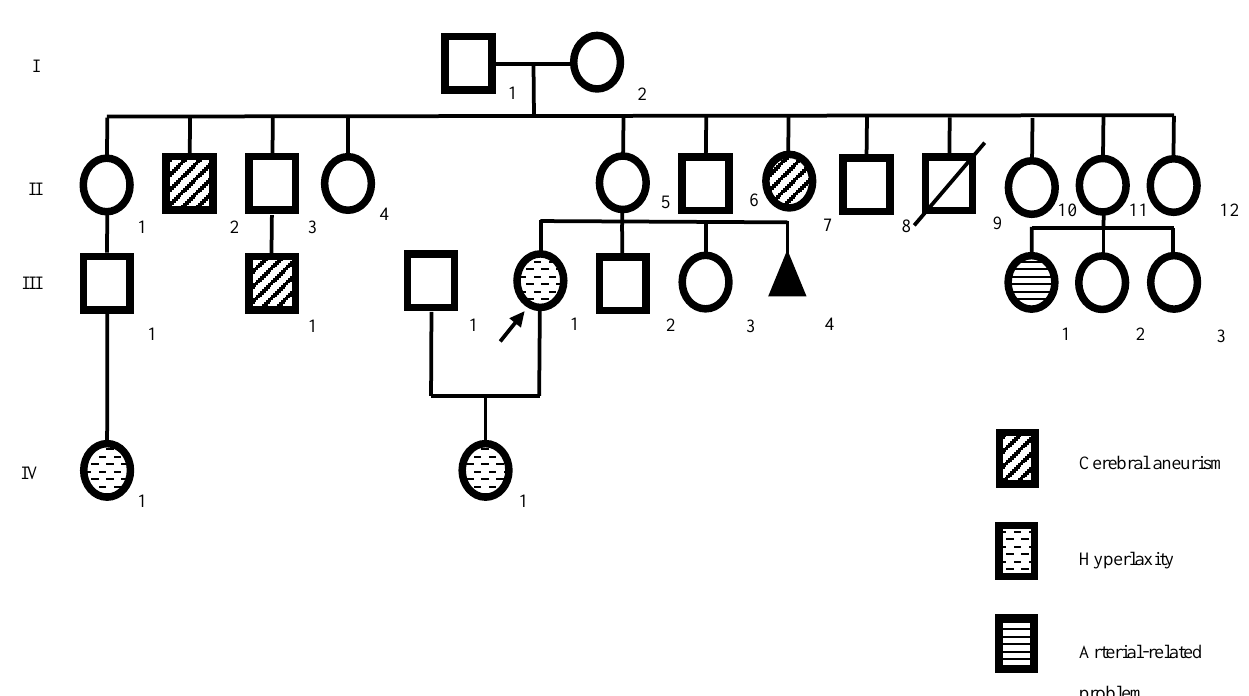
mandibular deviation to the left (Figure 2C), arachnodactyly, bruisability, muscular hypoto- nia, kyphoscoliosis, central Webber, Rinne+, lower and upper limb bowing, momentary contractures and involuntary hand movements were noted.